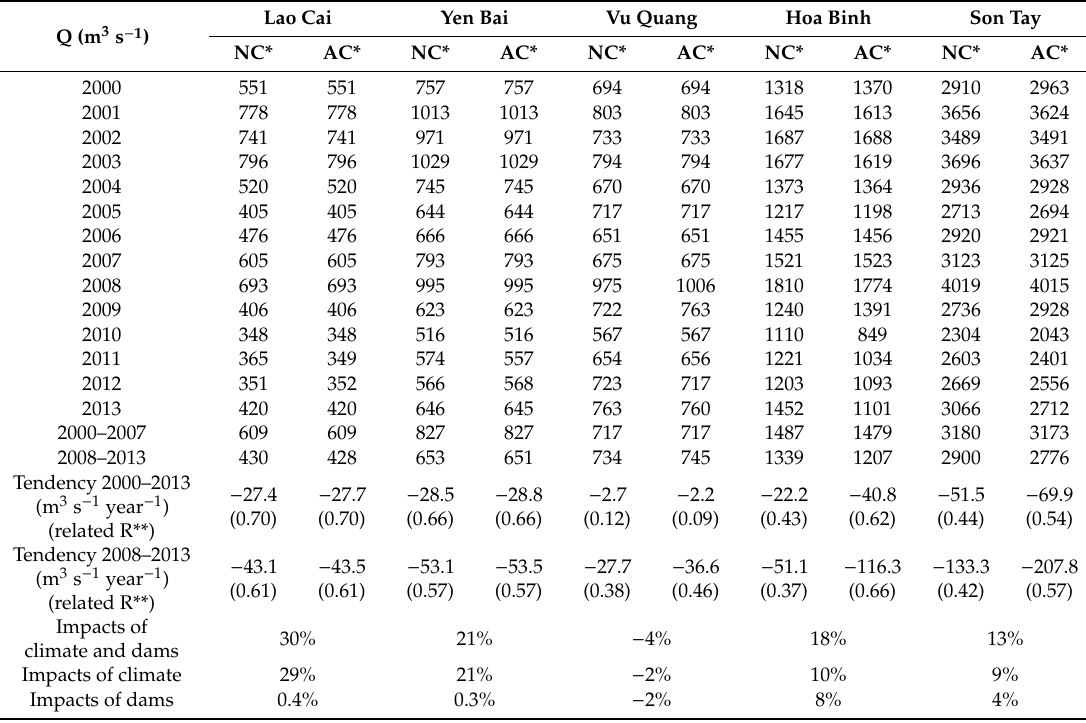
Table 6. Annual mean discharge (Q) from 2000 to 2013 and the multi-year annual mean Q of 2000–2007 (before new dams’ constructions) and 2008–2013 (after new dams’ constructions). Variation tendency of annual mean Q from 2000–2013 and 2008–2013. Impact percentages of climate variability and